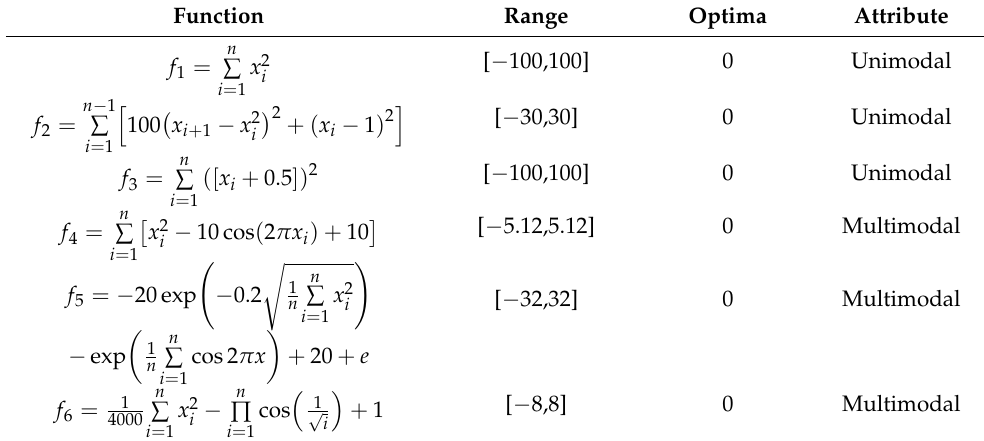
Table 1. Standard test functions.